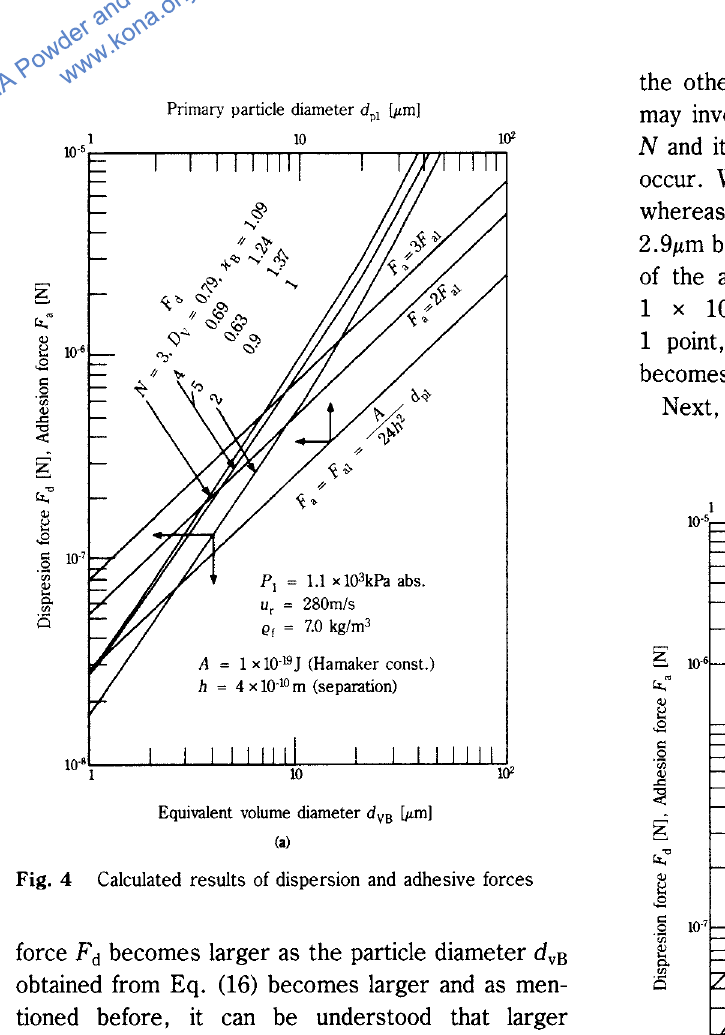
force Fct becomes larger as the particle diameter dvs obtained from Eq. (16) becomes larger and as men tioned before, it can be understood that larger aggregate particles become more prone to disperse.